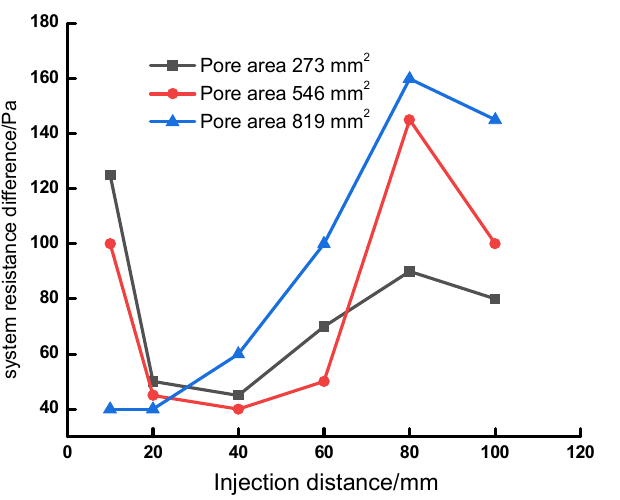
Figure 11. The system operation resistance difference of the cartridge with different nozzle areas and different jet distances at the pulse pressure of 0.4 MPa.